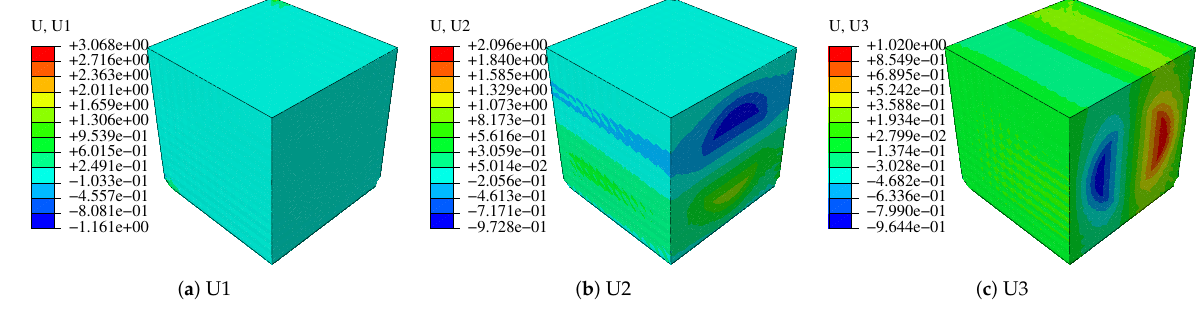
Figure 5. Characteristic displacement χ in the direction of